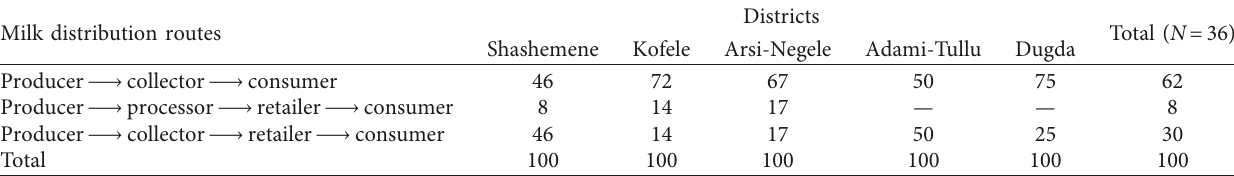
Table 3: The channel of milk distribution to the consumer